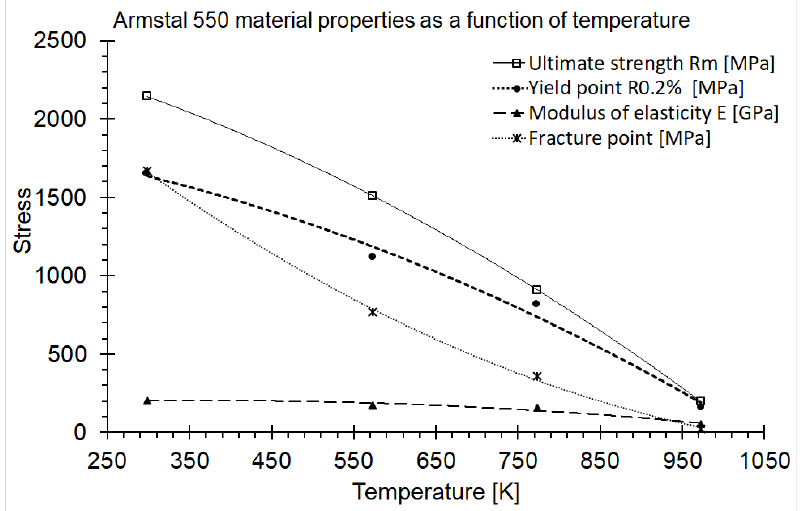
Figure 7. Graph of dependence of Armstal 550 mechanical properties on temperature.